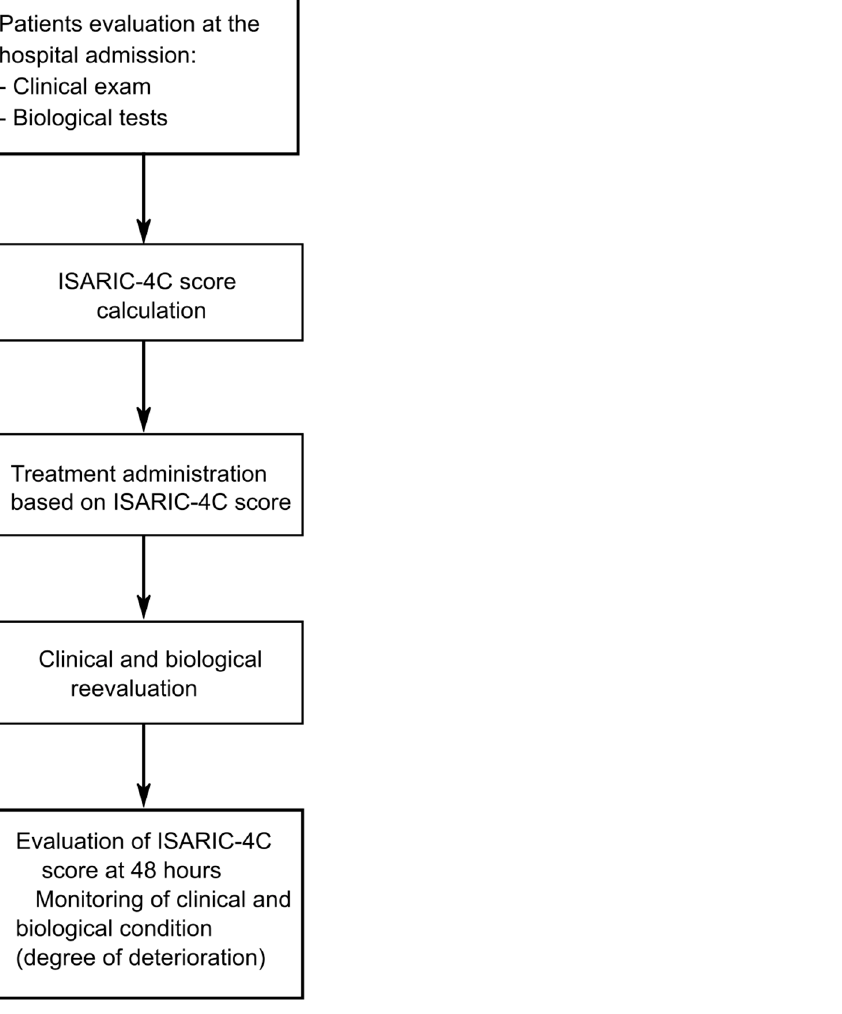
Figure 1. Diagram representing the process of the ISARIC-4C score application.